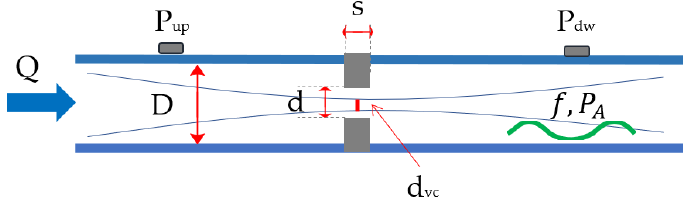
Figure 1. Characteristic parameters for the flow through an